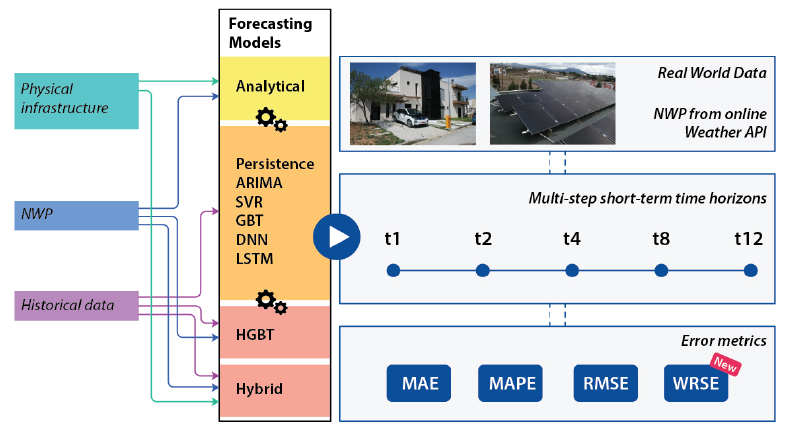
Figure 2. Overview of the methodology explored (each t corresponds to 15’